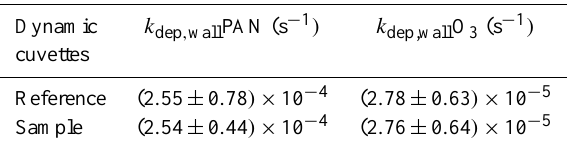
Table 4. Wall deposition rate of O 3 and PAN within the dynamic